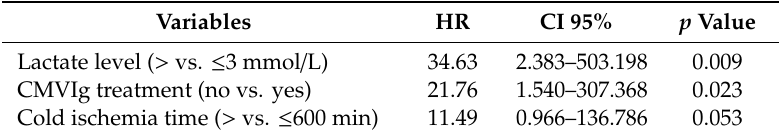
Table 4. Multivariate prognostic factors of 3-month